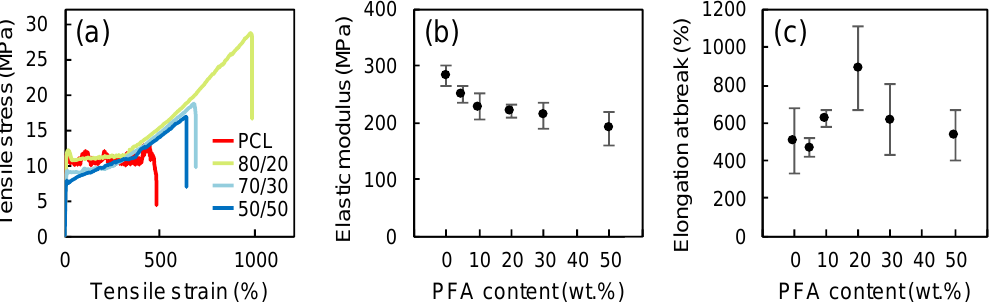
Figure 4. Representative stress-strain curves ( a ), elastic modulus ( b ), and elongation at break ( c ) of neat PCL and blends at di ff erent PCL / PFA proportions.